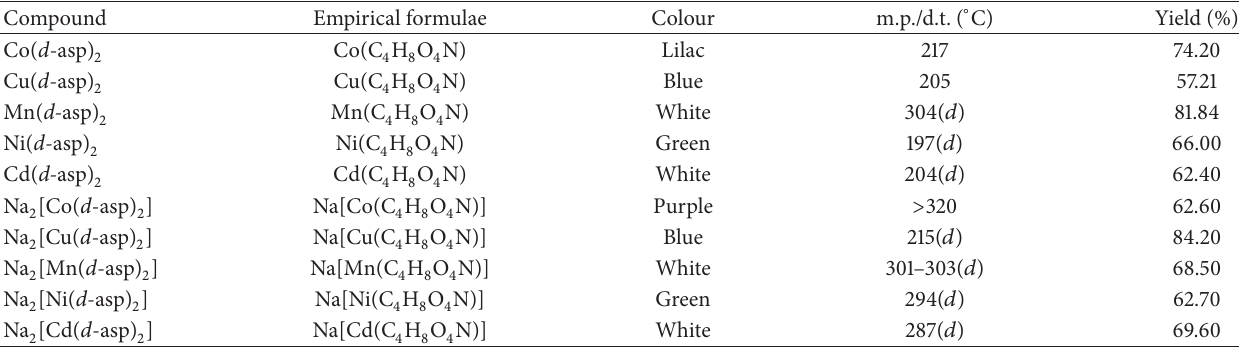
Table 1: Some physicochemical properties of the compounds.